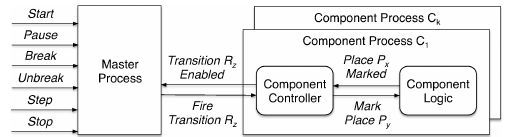
Figure 6: Actors involved in T-Net